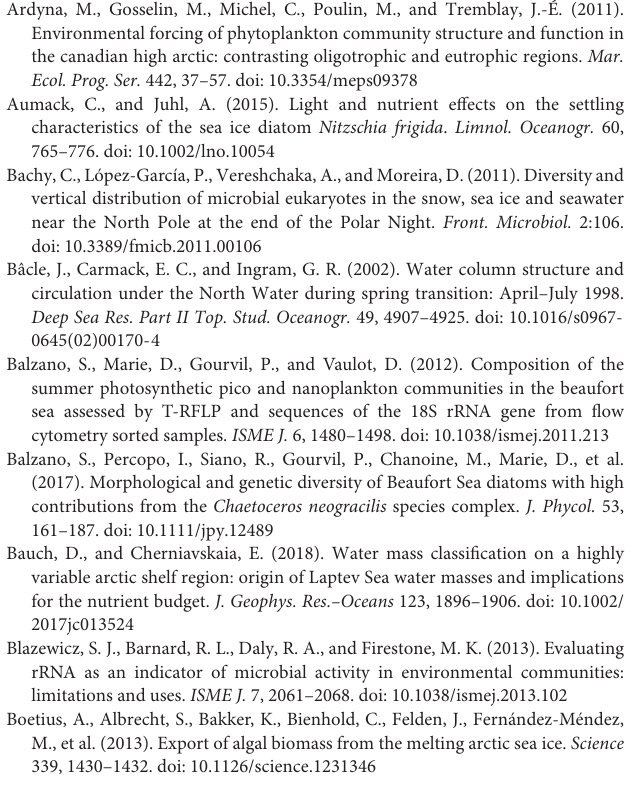
FIGURE S2 | Depth profiles of temperature (black), Chl a (green), nitrate concentration (red l), and density (blue) at the seven stations sampled.